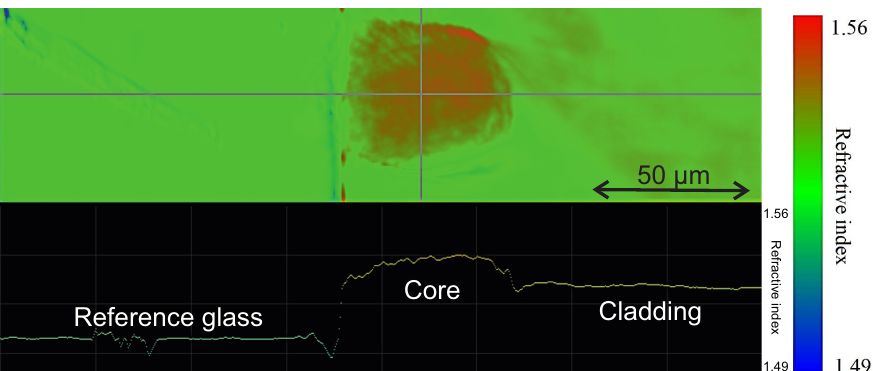
Figure 5. Measurement of the refractive index distribution of a SWW embedded in the cured cladding. The refractive index profile corresponds to the cross section along the horizontal line in the false colour image. The y-axis provides the refractive index value.